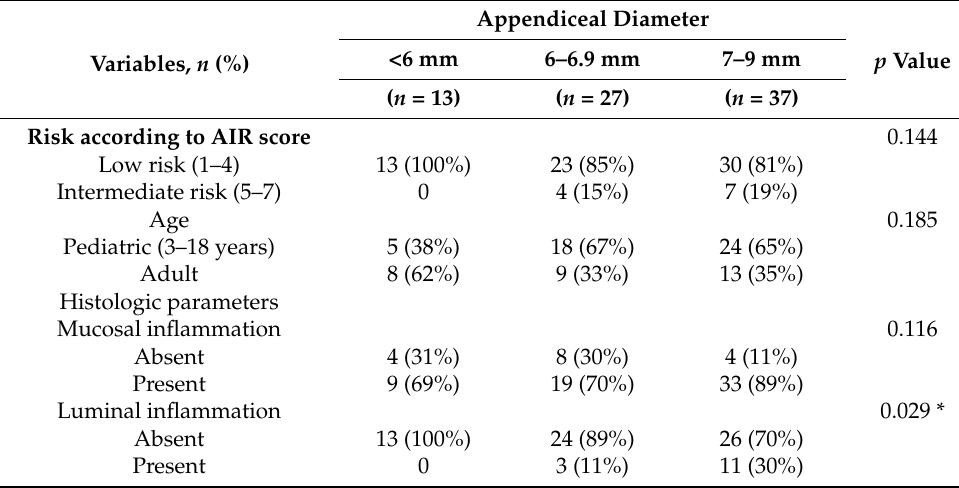
Table 2. Correlation between appendiceal diameter and AIR score and histologic parameters in 77 patients having available data for appendiceal